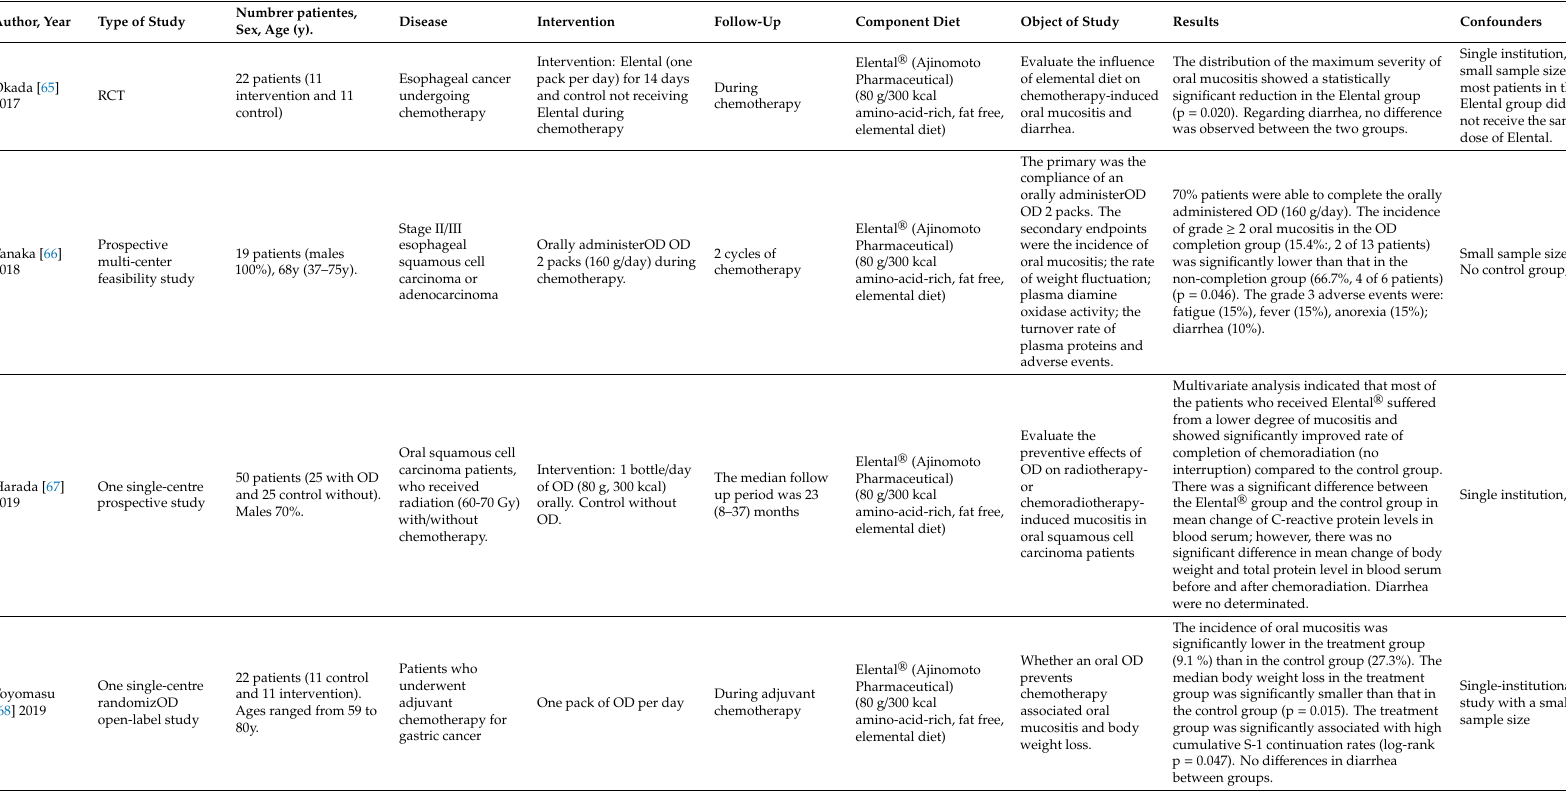
Table 3. Studies with oligomeric diet and chemotherapy-induced oro-intestinal